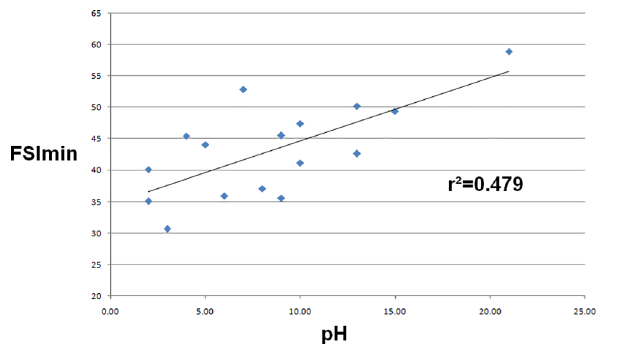
Fig 3. Correlation curve between FSI min and base